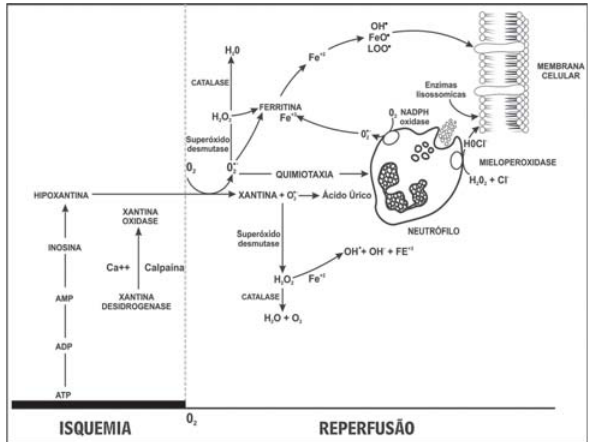
Fig. 1 - Eventos bioquímicos da isquemia-reperfusão, ativação de neutrófilos e mecanismos de